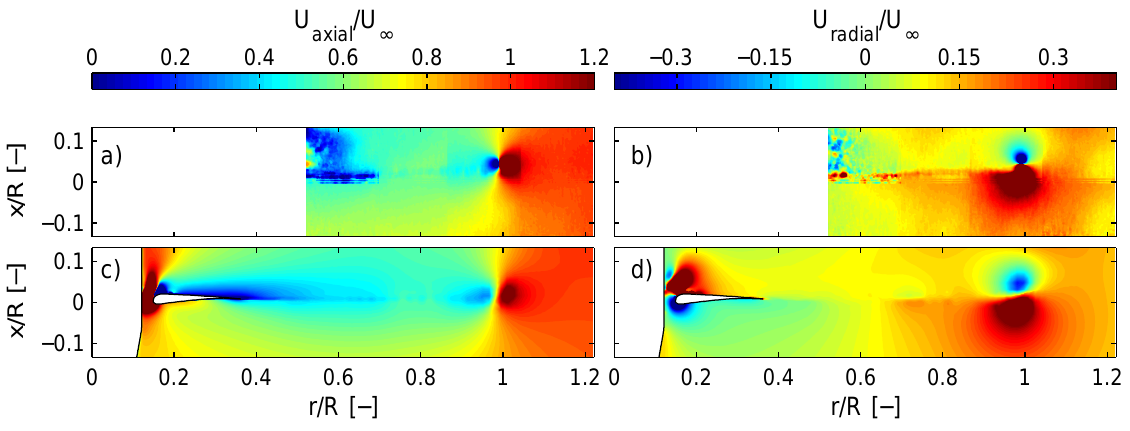
Figure 8. Measured and computed flow field at U 1 = 15 m/s. ( a ) axial wind speed from experiments; ( b ) radial wind speed from experiments; ( c ) axial wind speed from simulations; ( d ) radial wind speed from